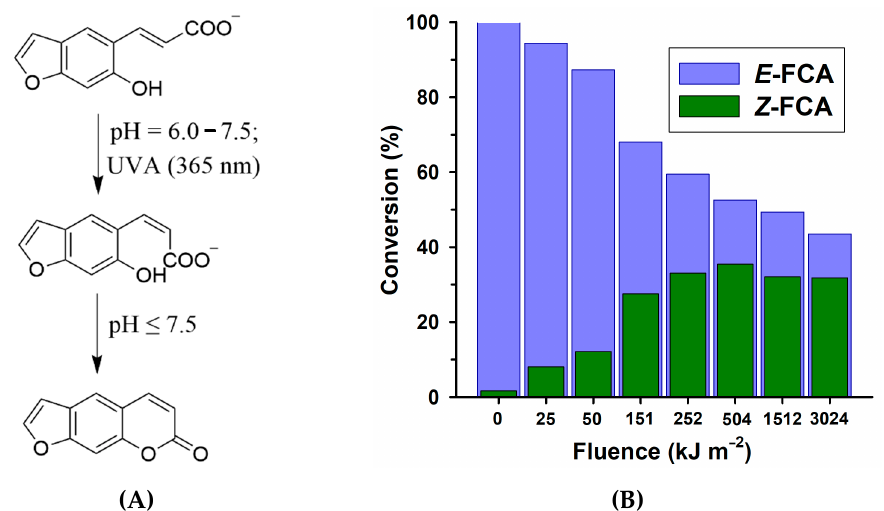
Figure 7. HPLC-controlled fluence-dependent E → Z conversion in E -FCA solutions (0.1 mM, 1% ethanol) UVA-irradiated at pH 6.5. ( A ) Reaction scheme. ( B ) Normalized conversion of E -FCA to Z -FCA as monitored by HPLC (raw HPLC data are presented in Figure S12).